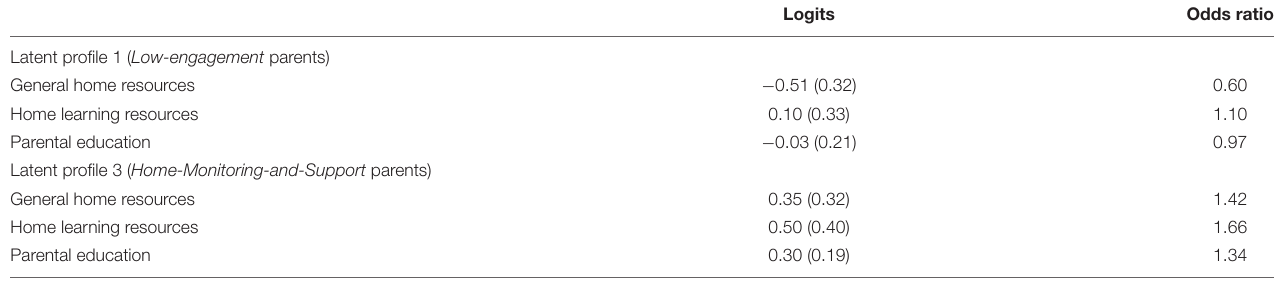
TABLE 7 | SES and latent profile membership (primary schools).